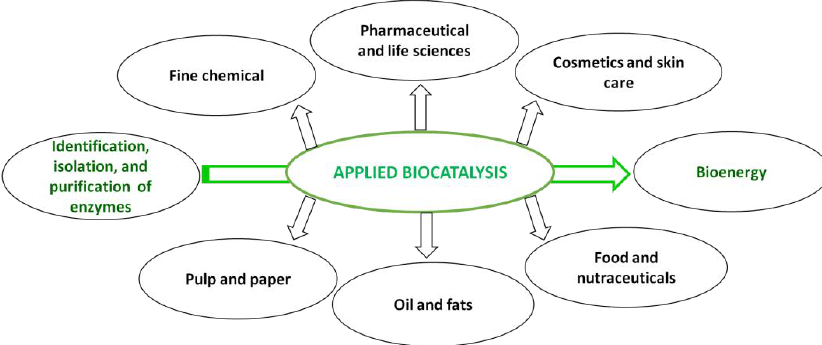
Figure 1. Highlights of seminal work conducted on the discovery and applications of enzymes.